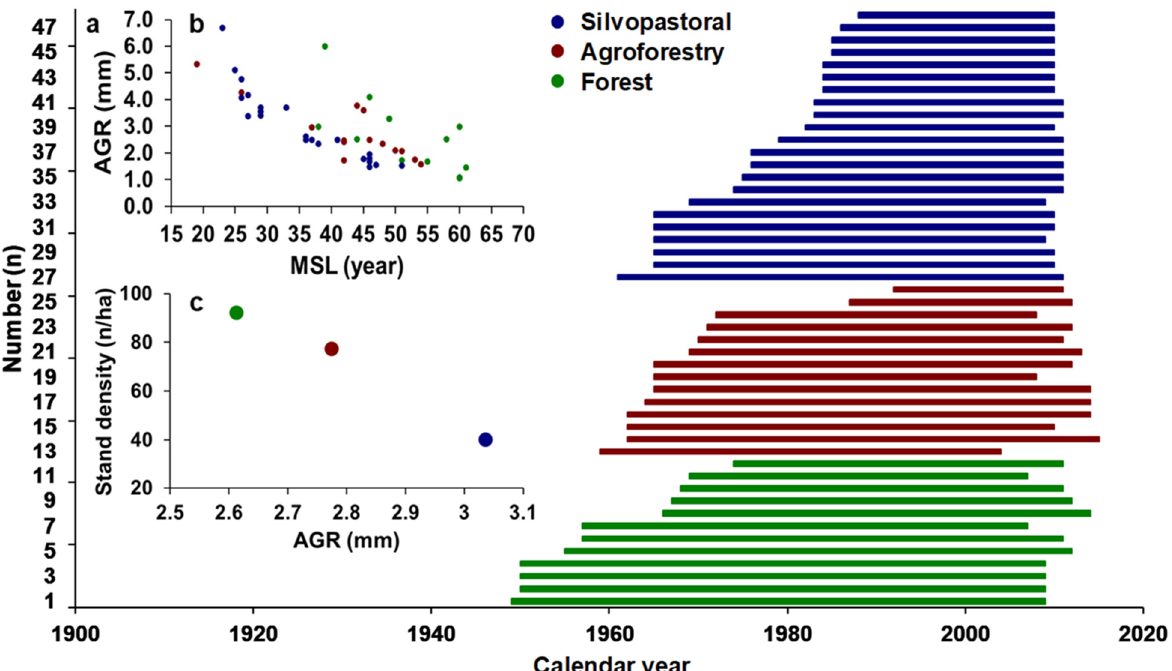
Figure 3. Temporal distribution of: ( a ) the 48 individual Quercus brantii Lindl. samples for the three sites; ( b ) relationship between average growth rate (AGR in mm/year) and mean segment length (MSL in years) of each sample; and ( c ) the relationship between stand density (n/ha) and average growths rate for each site.